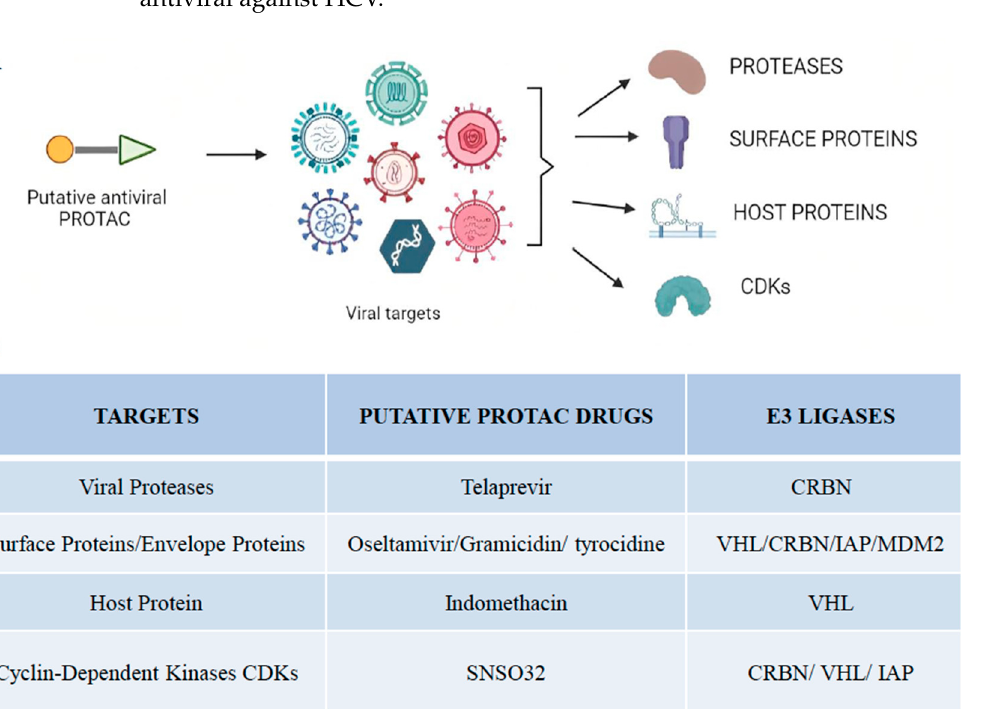
Figure 2. Viral targets of different PROTAC-based approaches. ( A ) Illustration of putative antiviral PROTACs targeting different viral targets, including proteases, surface proteins, host proteins, and cyclin-dependent kinases. ( B ) Summary of viral targets and their putative antiviral drugs and E3 ligases that make up the PROTAC molecule.